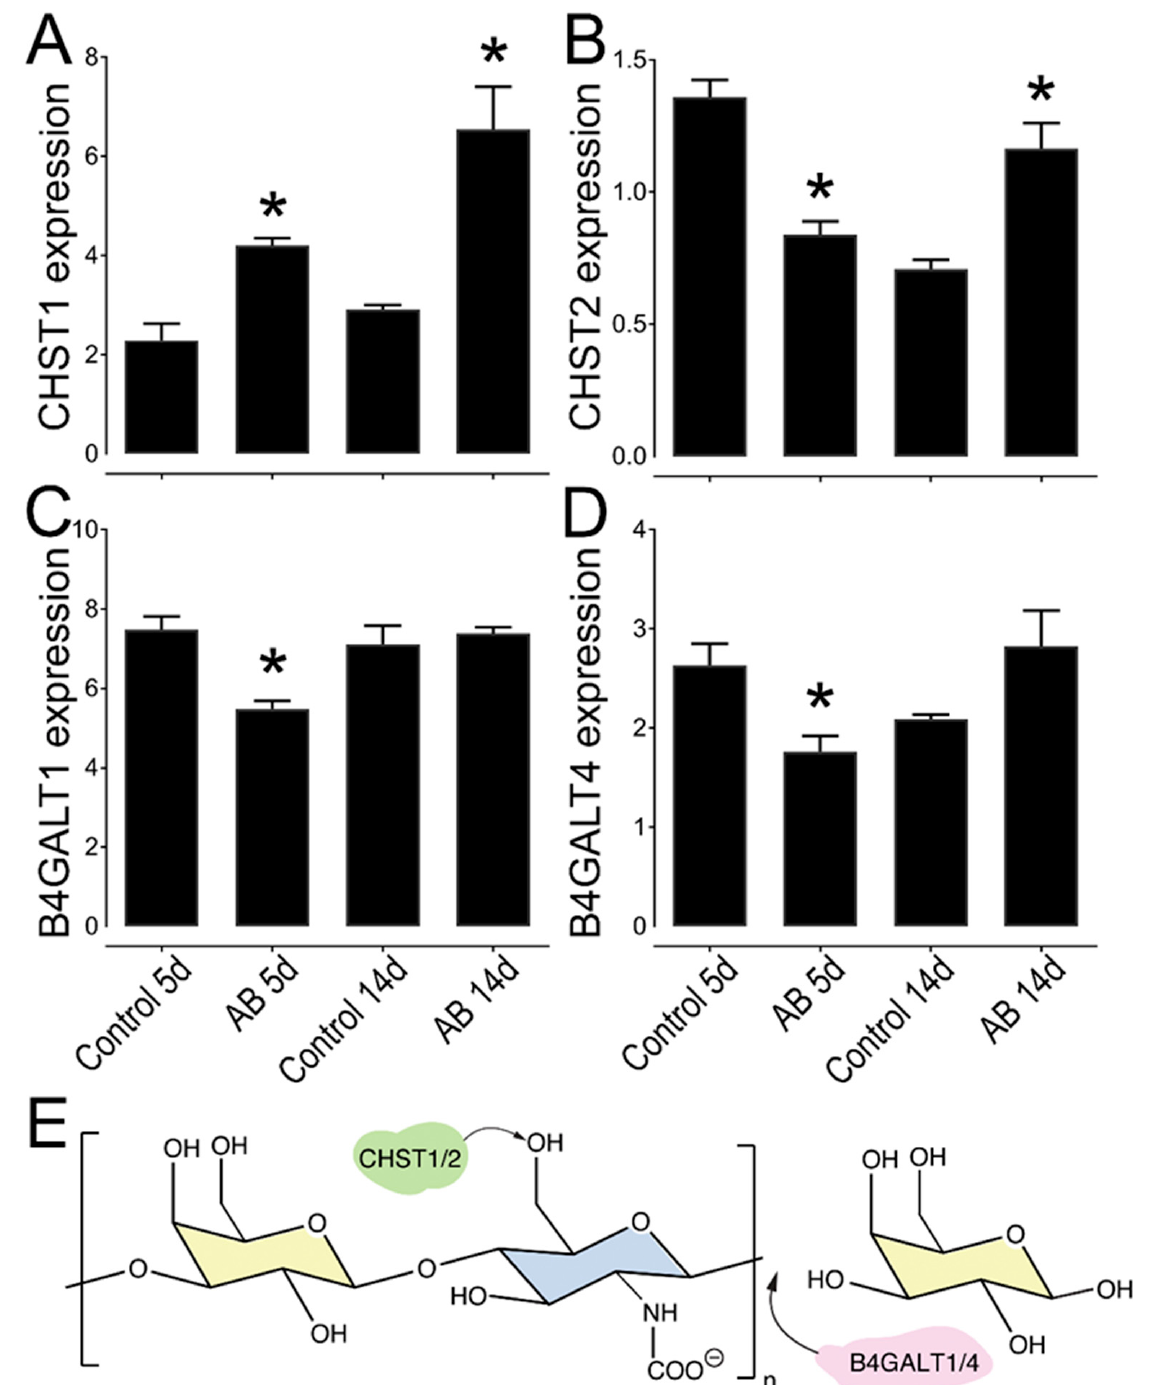
Figure 8. Relative expression profile of KS biosynthetic enzymes in mouse corneas after AB. Mouse corneas were subjected to AB and analyzed after 5 and 14 days, compared to the contralateral uninjured eye. Real-time PCR analysis (qPCR) was done to verify the expression levels of CHST1 ( A ), CHST2 ( B ), B4GALT1 ( C ), and B4GALT4 ( D ). The relative expression levels were normalized against GAPDH using the 2 − ∆ Ct method. * represents p ≤ 0.05. Five corneas were analyzed per experimental group. Schematic representation of the activity of each enzyme analyzed, CHST1 and 2 catalyze the transfer of a sulfate to the position 6 of galactose, while B4GALT1 and 4 catalyze the transfer of a galatose residue to the polymerizing KS chain ( E ). Table 3. Identification of KS biosynthetic enzymes by RNAseq analysis.